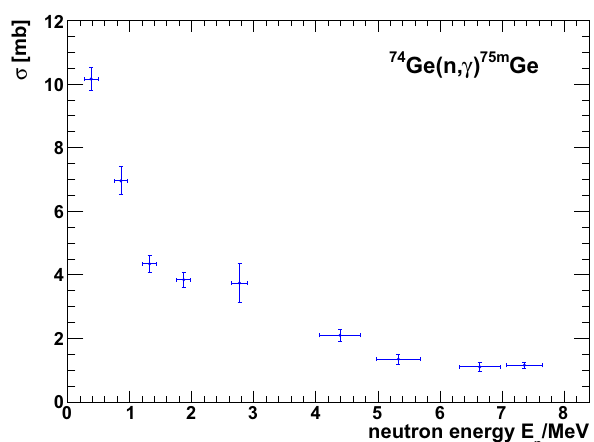
Fig. 2 Pulse height spectrum of a 3 He-filled proportional counter acquired after three days of measurement during the reactor ON period. The solid blue line depicts the total fit function including the back- ground. The solid red line shows the fit function describing the neutron- induced component of the PHS